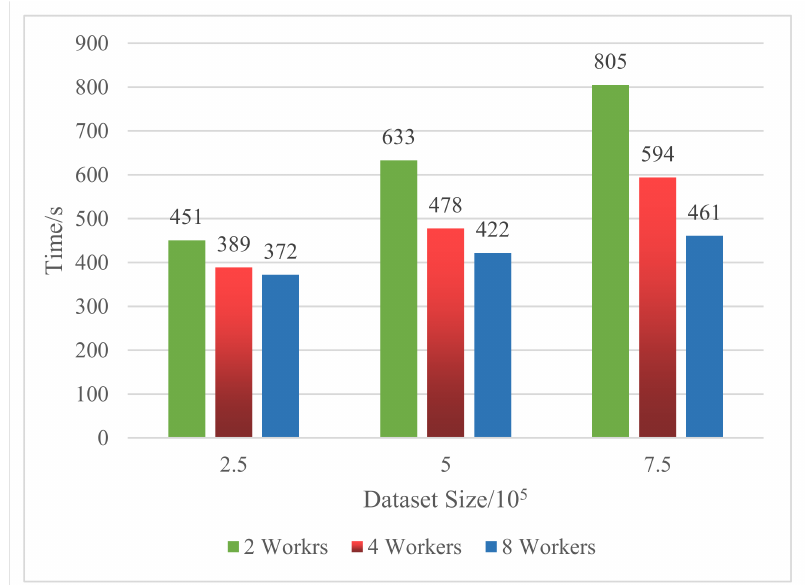
Figure 6. Build time of